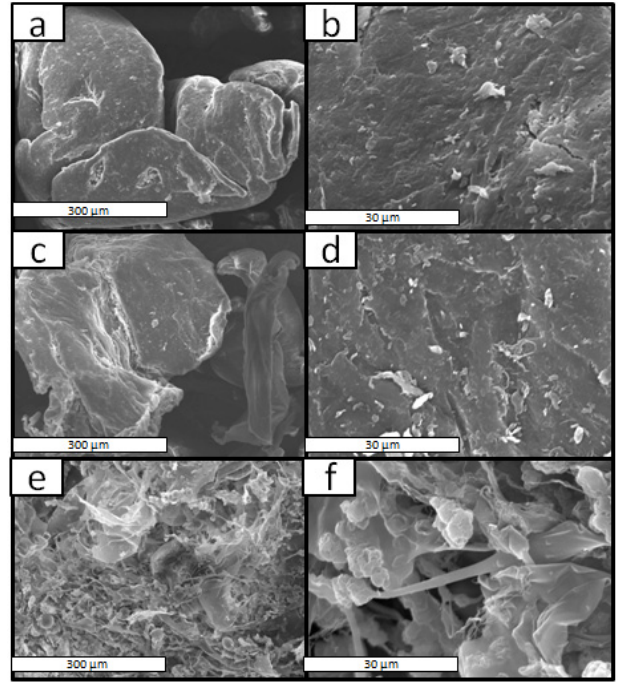
Figure 3. SEM micrographs of the surface of (a , b ) PLA, ( c , d ) chitosan and ( e , f ) Ch-PLA, at ( a , c , e ) 200× and ( b , d , f ) 2000×